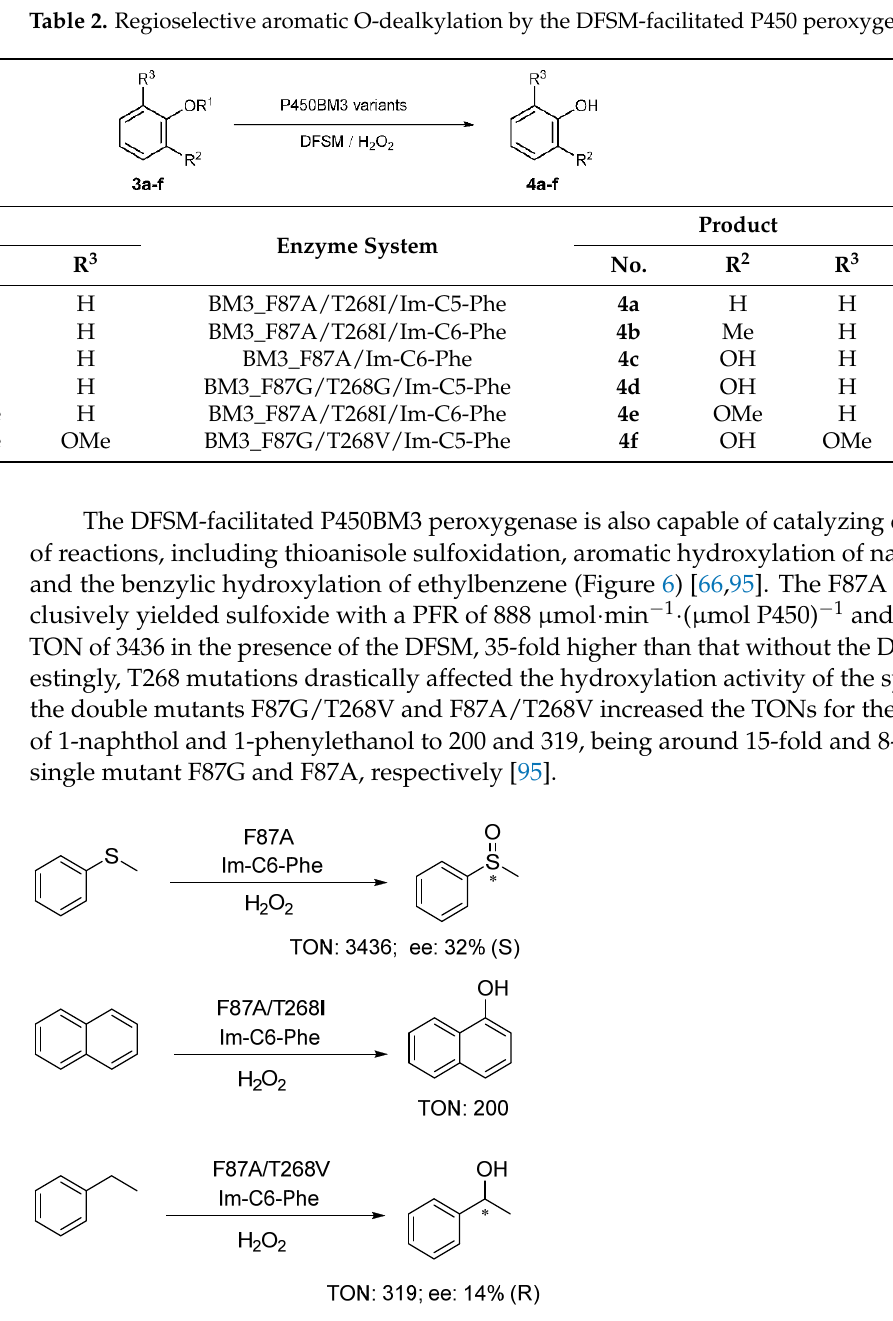
Figure 6. DFSM-facilitated P450 peroxygenases catalyzed sulfoxidation and hydroxylation.